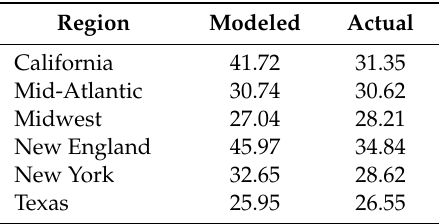
Table 1. Annually-averaged prices ($ / MWh) by region, comparing modeled prices with 2016–2018 historic